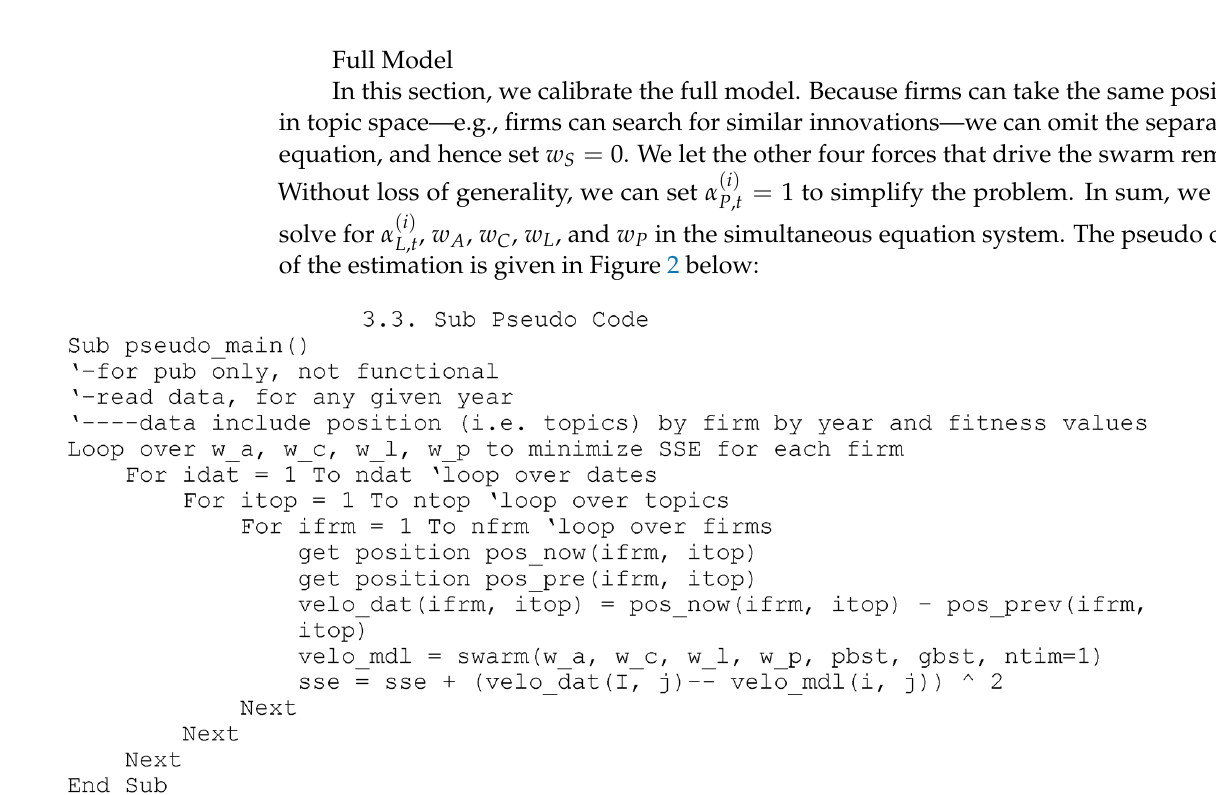
Table 6. Full model weights by